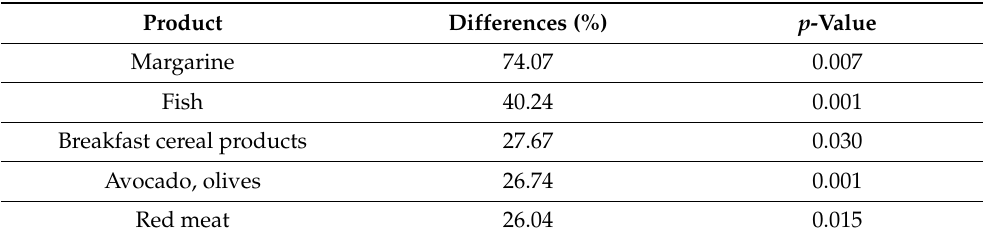
Figure 1. Differences in food preferences between patients with PD and the healthy controls. Table 3. The frequency of products consumed by patients with PD compared to the healthy controls. Table 3 shows the products with higher intake in patients with PD compared to healthy